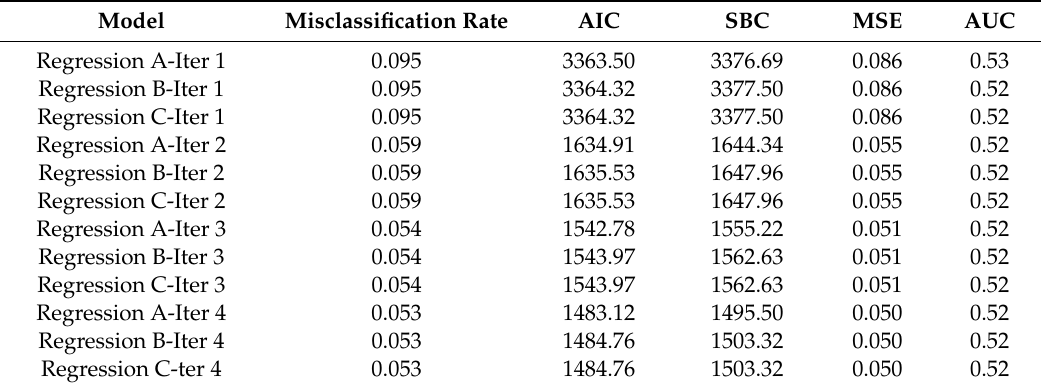
Table 11. First iterations of training test of the best regression models.